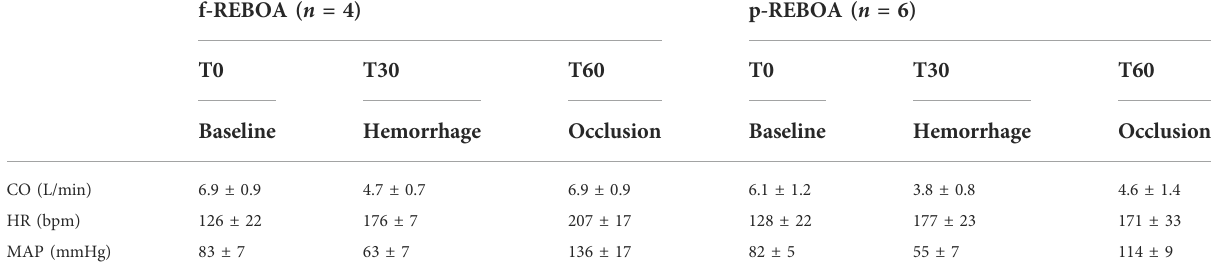
TABLE 1 Porcine hemodynamic characteristics in the f-REBOA and p-REBOA